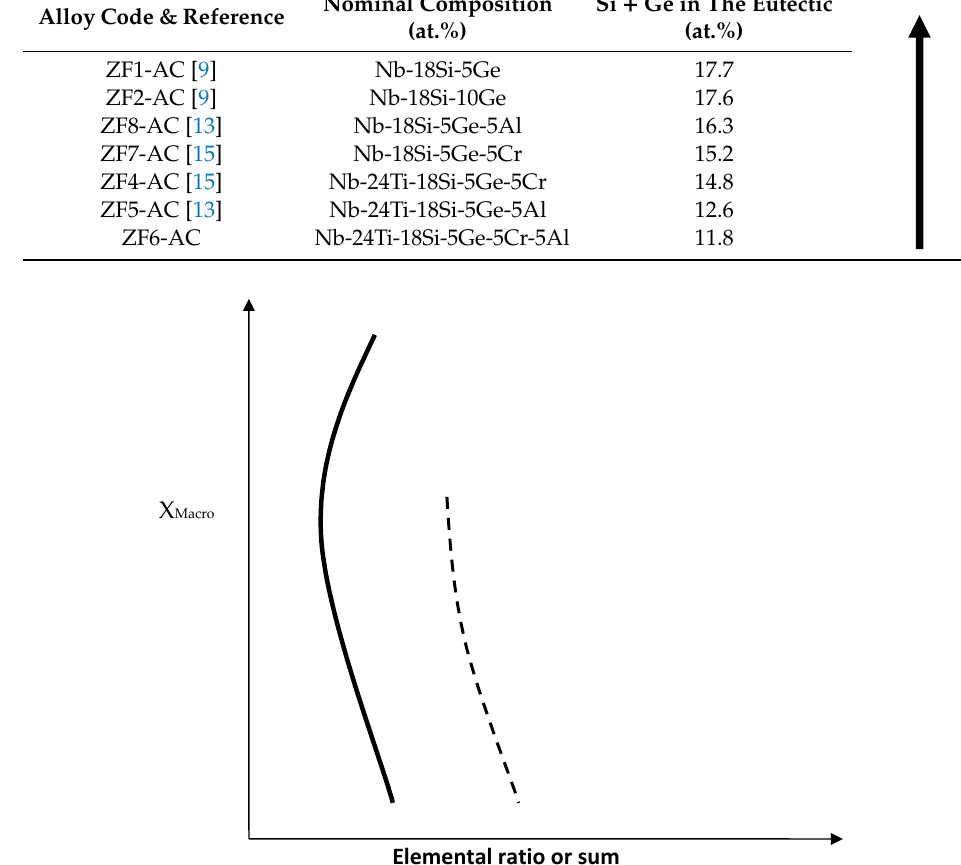
Figure 6. Schematic diagram showing the dependence of the macrosegregation of element X (vertical axis) on the alloying elements in specific phases in Nb silicide-based alloys. The ranges of X values are given in Tables 6 and 7. Chemical analysis data for the Nb ss + Nb 5 Si 3 eutectic in Ge containing Nb silicide based alloys is given in the Tables 8 and 9. The chemical analysis data for specific phases in Nb silicide based alloys can be found in the references given in Tables 6–9. The thick line shows (a) how the Si macrosegregation varies with (Si + Ge) eutectic (range 11.8 to 17.7, nose ZF6), (Si / Al) Nb5Si3 (range 4.8 to 9.5, nose ZF9), (Si / Cr) Nb5Si3 (range 16.6 to 24, nose ZF6), (Si / Al) Nbss (range 0.21 to 0.49, nose ZF6), (TM / SM) Nbss (range 2.7 to 3.8, nose ZF5), (TM / SM) Ti rich Nbss (range 3.4 to 5.6, nose ZF5), (Si / Cr) Nbss (range 0.1 to 0.28, nose ZF9) and (Ti / Cr) Nbss (range 2.1 to 3.6, nose ZF9), (b) how the Ti macrosegregation varies with (Si / Cr) Nb5Si3 (range 16.6 to 24, nose ZF6) and (Si / Al) Ti rich Nb5Si3 (range 4.4 to 8.7, nose ZF6), (Ti / Cr) Nb5Si3 (range 14.9 to 17.5, nose ZF4) and (Ti / Cr) Ti rich Nb5Si3 (range 9.8 to 30, nose ZF4) and (c) how the Cr macrosegregation varies with (Si / Cr) Nbss (range 0.1 to 0.28, nose ZF9). X = Si, Ti, Cr and TM = Ti + Cr + Hf, SM = Si + Ge + Al. The dashed line shows (d) how the macrosegregation of Si varies with (Si / Al) Ti rich Nb5Si3 (range 4.3 to 8.7) and (Si + Al + Ge) eutectic (range 18.1 to 22.6) and (e) how the Ti macrosegregation varies with (Si / Al) Nb5Si3 (range 4.8 to 9.5) and (Si / Al) Nbss (range 0.21 to 0.33), X = Si,